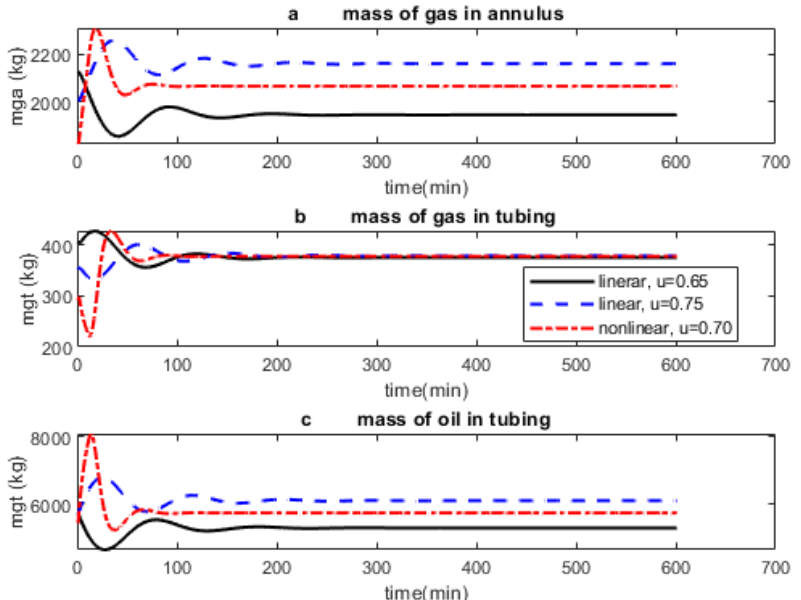
Figure 6. Linear and nonlinear states of the gas-lifted system for u = 0.70. The linear states do not converge to the nonlinear